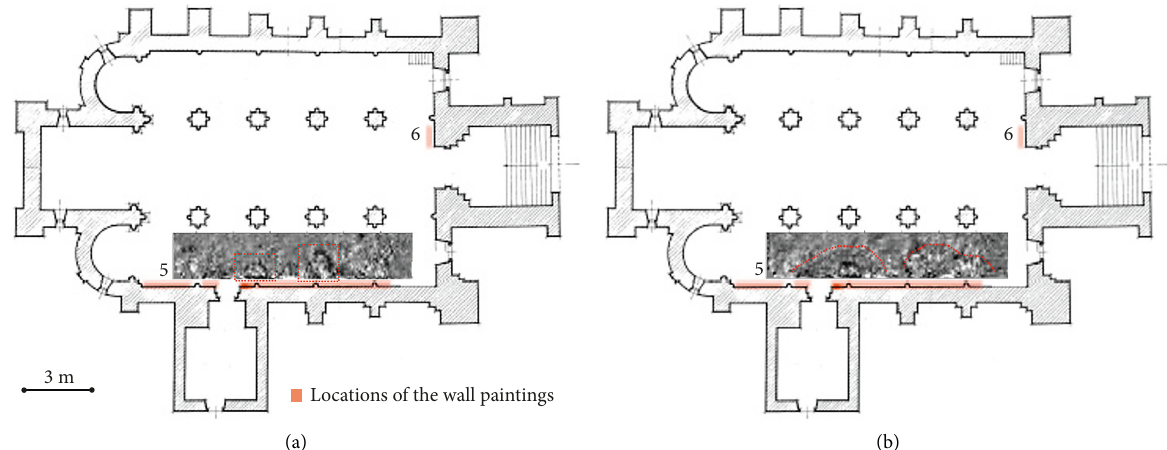
Figure 10: 3D GPR imaging: time-slices at depths of 50cm (a), and 60cm